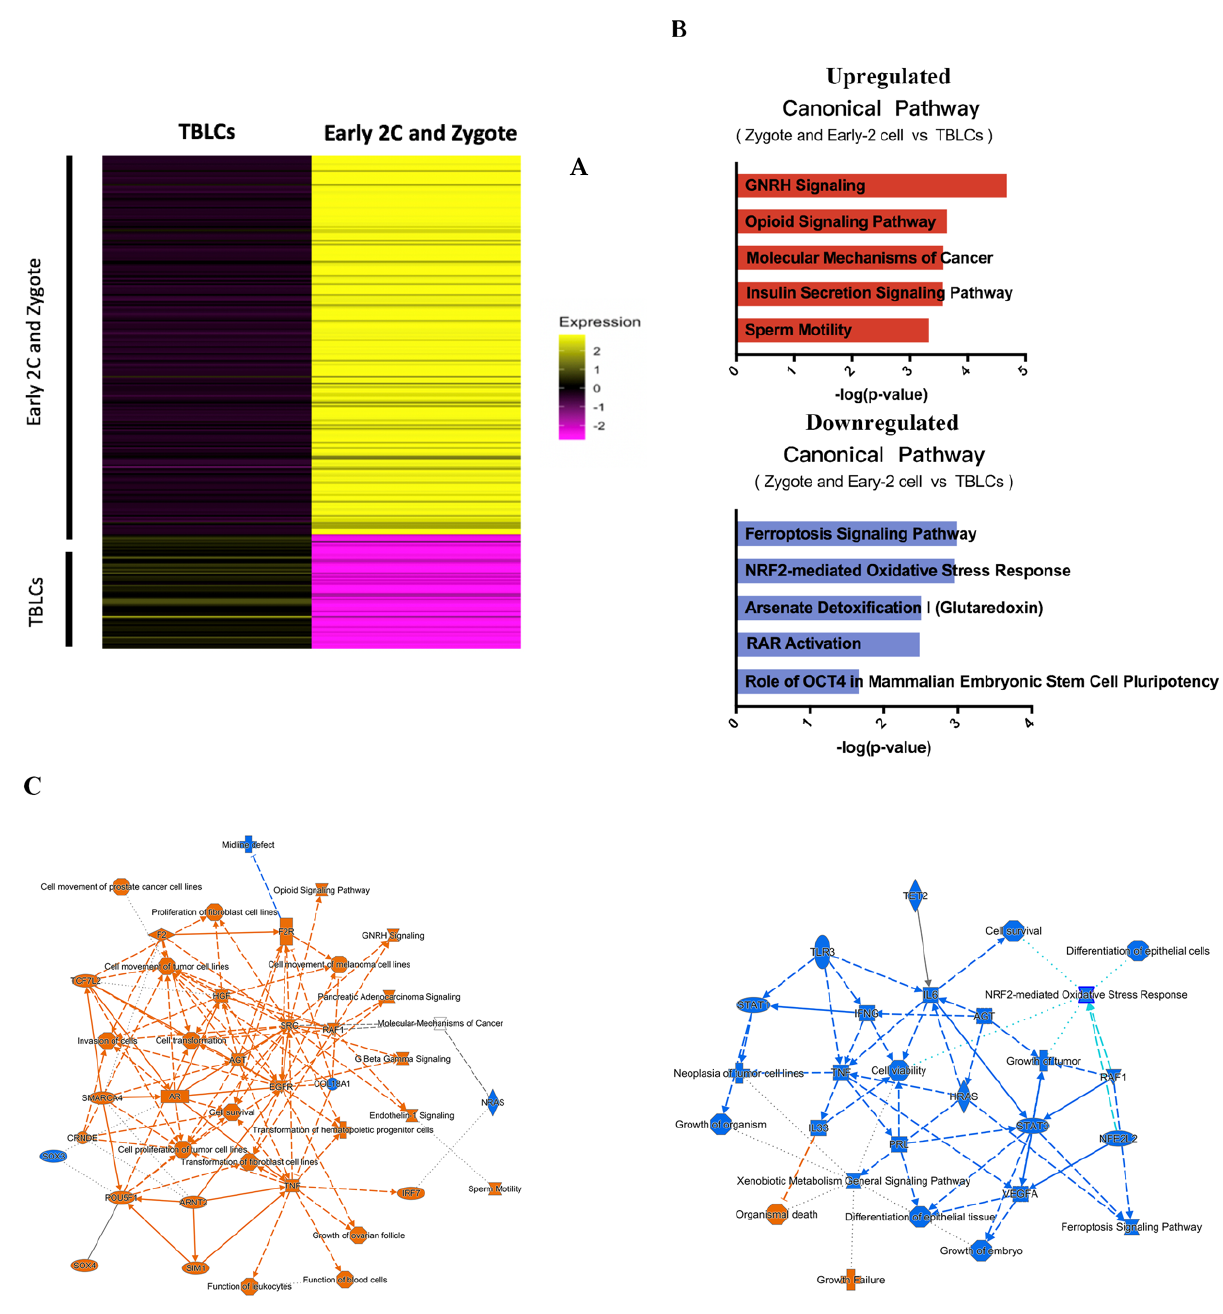
Figure 4. Differential gene and pathway analyses of TBLCs and zygote-early 2-cells. ( A ) Heatmap showing the average differential gene expression patterns of zygote-early 2-cells (top) and TBLCs (bottom). Scale bar indicates z-scored gene expression value. ( B ) Top 5 canonical pathways derived from ingenuity pathway analysis (IPA) gene ontology of gene markers of zygote-early 2-cells (top) and TBLCs (bottom). ( C ) Graphical summary of the predicted pathway regulation for zygote-early 2-cells (left) and TBLCs (right) gene markers. Orange lines indicate upregulation while blue lines indicate downregulation.